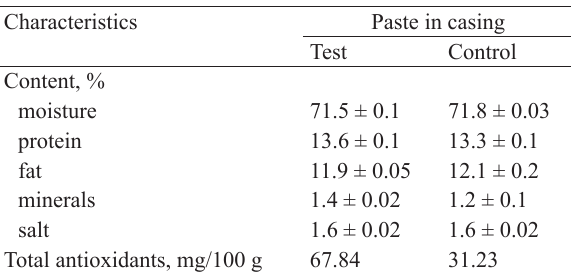
Table 4 Physicochemical characteristics of paste in